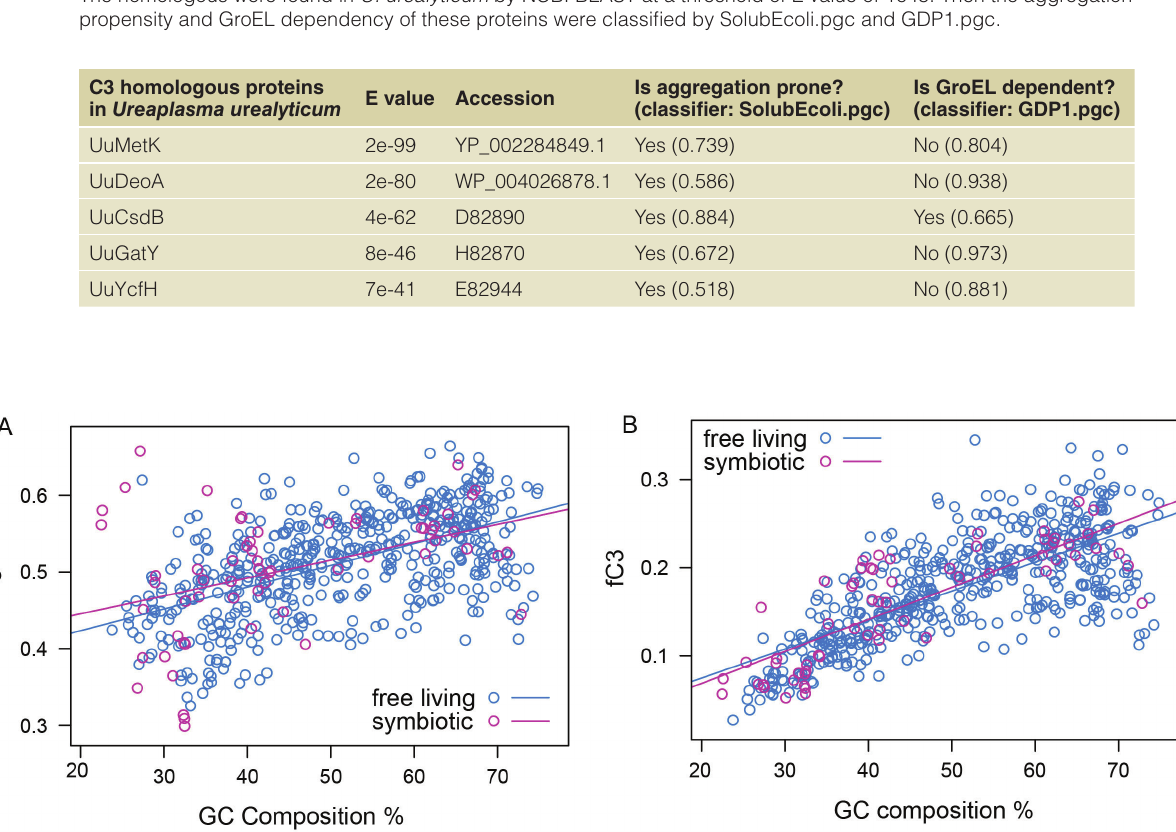
Figure 7. fAG and fC3 are correlated to the GC content independent from the species habitat. The ANCOVA test on 570 organisms showed that a symbiotic relationship has no significant effect or interaction with GC content on the aggregation propensity or GroEL-dependency of the proteins of an